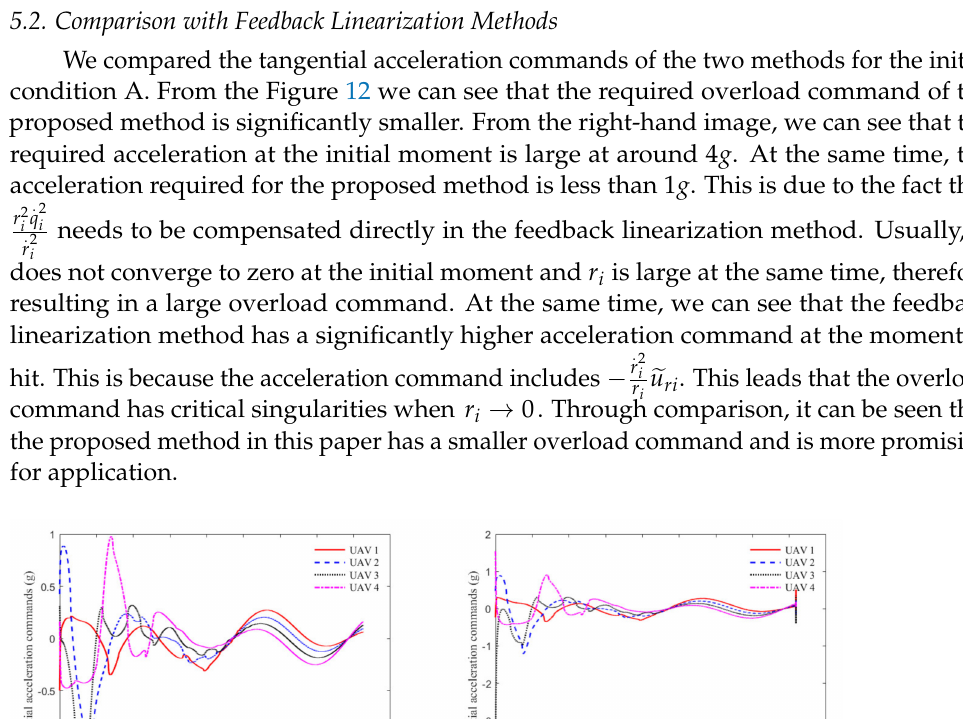
Figure 11. Tangential overload commands.